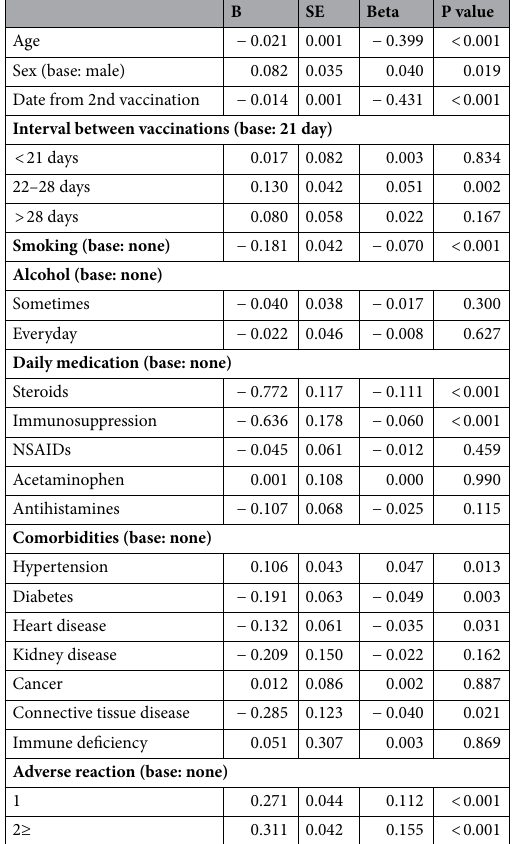
Table 2. Linear regression analysis of variables associated with IgG antibody titre after BNT162b2. Connective tissue disease included Rheumatism. Adverse reaction included whole body adverse reaction at 2nd